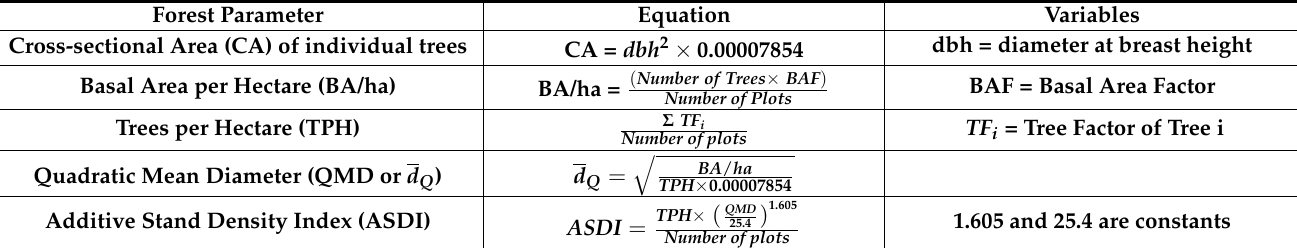
Table 1. Forest biometric equations for the stand level characterizations of structure and composition. Forest Parameter Equation Variables Cross-sectional Area (CA) of individual trees CA = dbh 2 × 0.00007854 dbh = diameter at breast height Basal Area per Hectare (BA/ha) BA/ha = ( Number of Trees × BAF ) BAF = Basal Area Factor Number of Plots TF i = Tree Factor of Tree i Trees per Hectare (TPH) Σ TF i Number of plots (cid:113) BA / ha Quadratic Mean Diameter (QMD or d Q ) d Q = TPH × 0.00007854 1.605 Additive Stand Density Index (ASDI) ASDI = TPH × ( QMD 25.4 ) 1.605 and 25.4 are constants Number of plots Basal area is a useful characteristic for defining the composition of forest stands